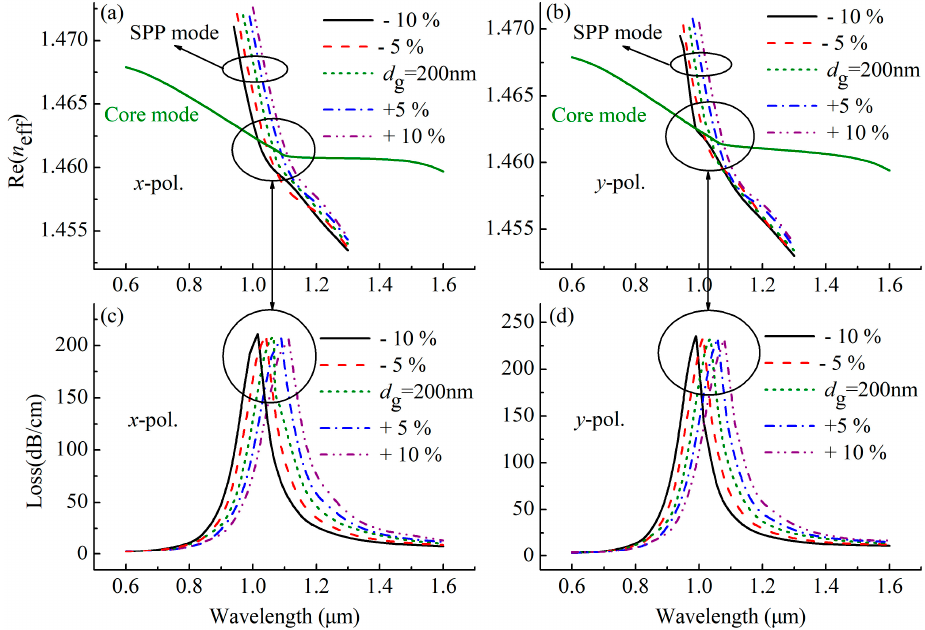
Figure 9. ( a ) Dispersion relations of the x -polarized core mode and SPP mode, ( b ) dispersion relations of the y -polarized core mode and SPP mode, ( c ) losses as a function of wavelength for the x -polarized core mode and ( d ) losses as a function of wavelength for the y -polarized core mode at n = 1.47, with varying gold nanowire ( d g ).